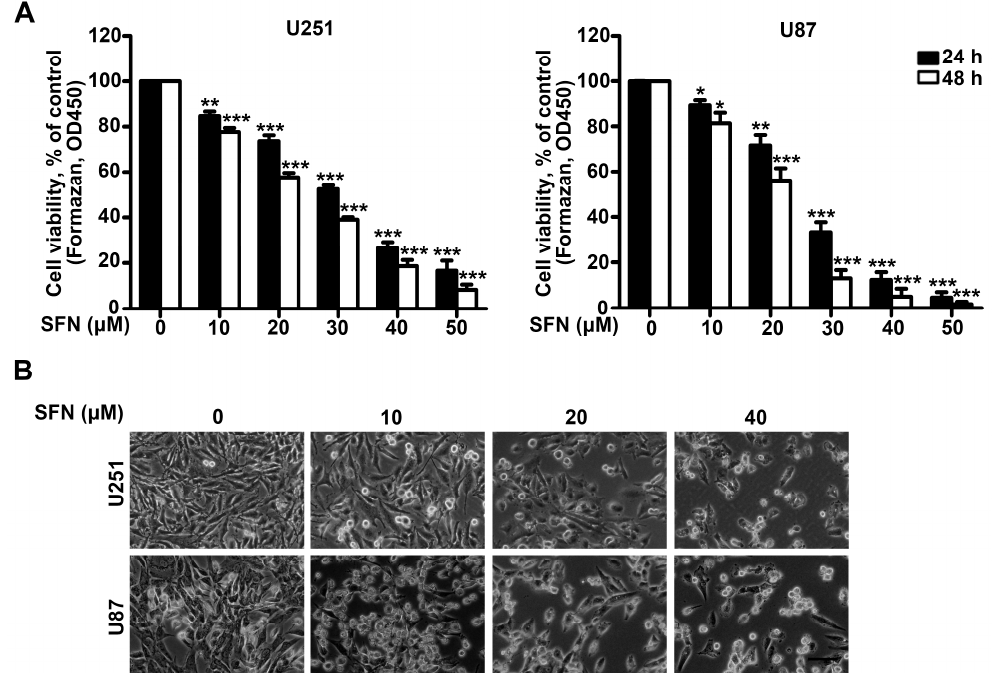
Figure 1. Reduced viability and morphological changes in GBM cells after SFN treatment. ( A ) Cell viability was analyzed by the CCK-8 assay when U251 and U87 cells were cultured and treated with SFN (0, 10, 20, 30, 40, 50 µM) for 24 and 48 h; and ( B ) cell morphological changes following the indicated treatment for 24 h were examined and photographed. Bar: 100 µm. Data are shown as mean ± SD. * p < 0.05, ** p < 0.01, and *** p < 0.001 versus control group.